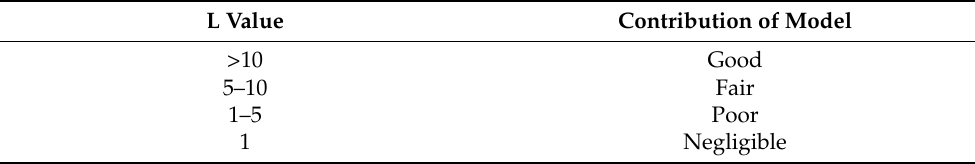
Table 3. Interpretation of Thresholds of Positive